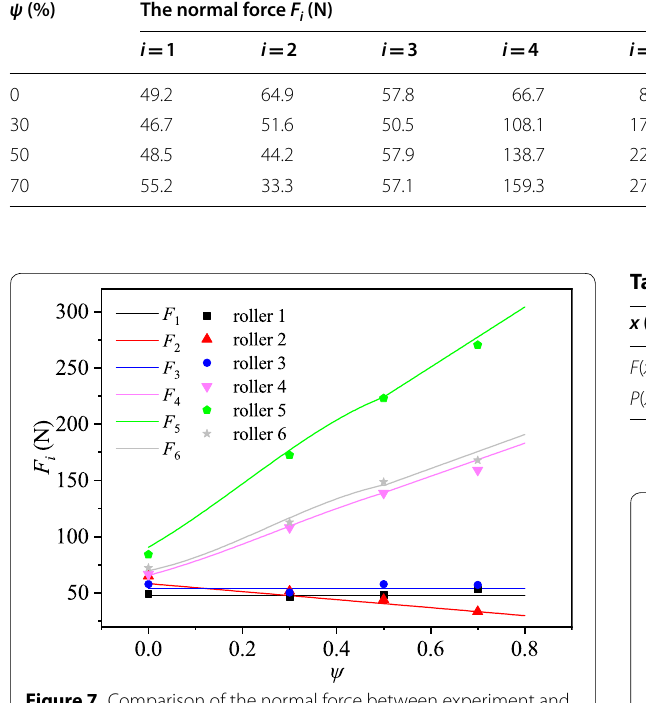
Figure 7 Comparison of the normal force between experiment and the calculation formula